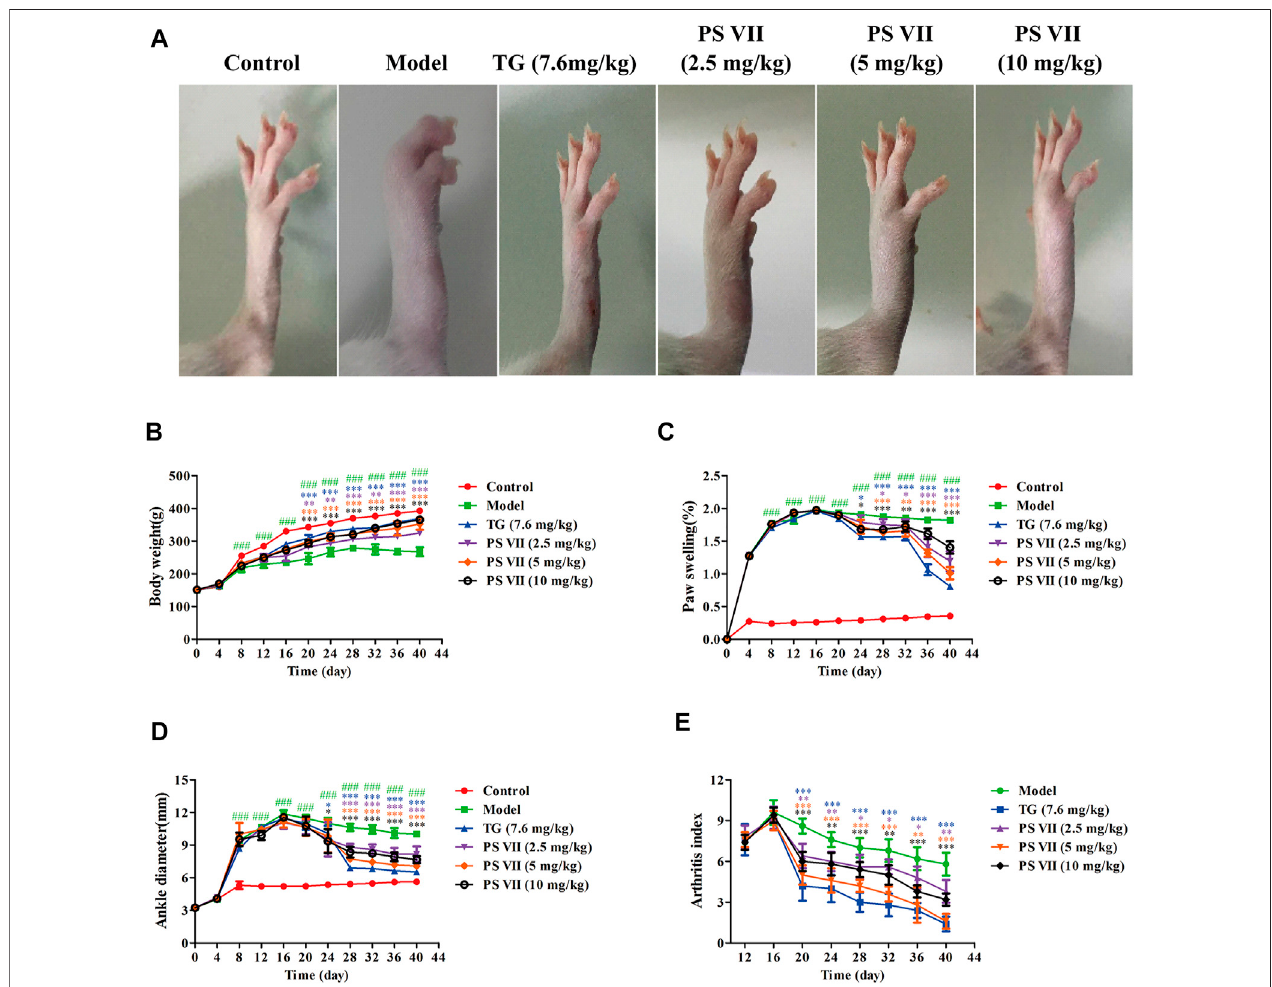
FIGURE9| EffectsofPSVIIontheseverityofAIArats.AftertheestablishmentoftheAIAmodel,ratswereintragastricallyadministeredPSVII(2.5 mg/kg,5 mg/kg, 10 mg/kg)andTG(7.6 mg/kg)everyday.Thecontrolgroupandthemodelgroupweregivenanequalvolumeof0.5%CMC-Na. (A) Morphologicalrepresentationofthe right hind paw of rats from six groups on the day 40 after CFA injection. Observe body weight (B) , paw swelling (C) , ankle joint diameter (D) , and arthritis index (E) every 4 days. Data were expressed as mean ± SD ( n (cid:2) 5). Compared with the control group, ### p < 0.5, compared with the model group, * p < 0.05, ** p < 0.01, *** p <